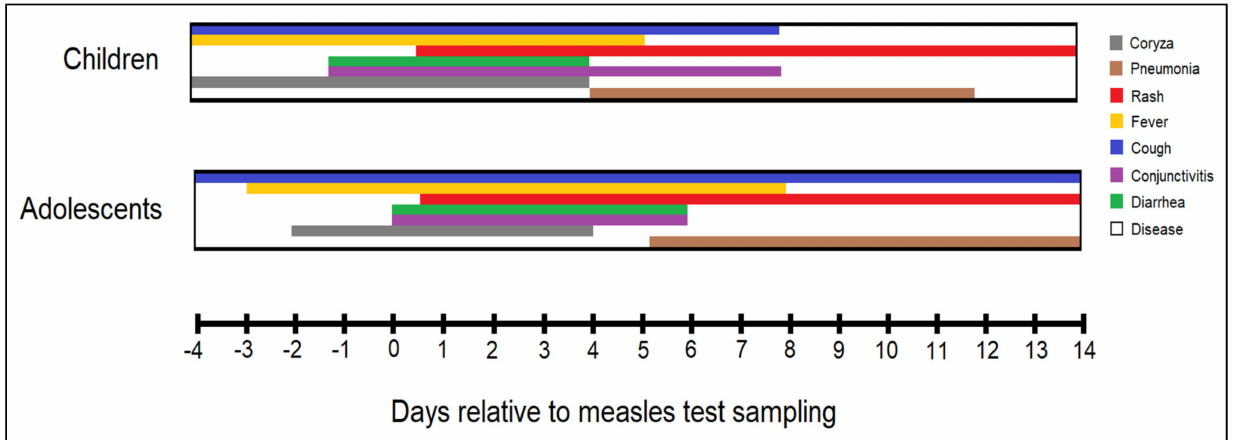
Figure 2. Timeline of measles signs and symptoms occurrence and duration, stratified between children and adolescents relative to measles IgM test sampling. Day 0 is considered the date of IgM antibody